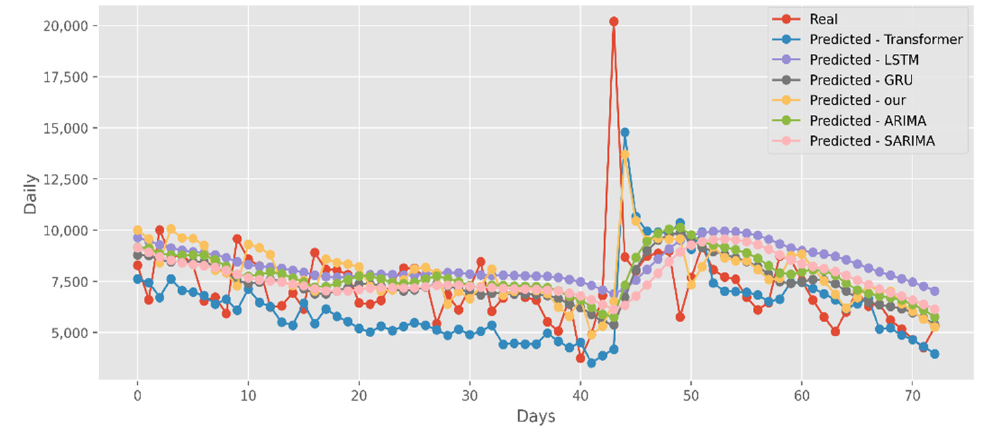
Figure 13. Comparison of COVID-19 prediction models of cases in NY.